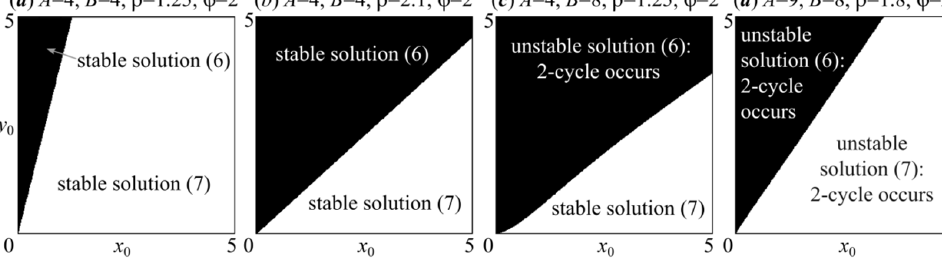
Figure 3. Attraction basins of bi-stable dynamics modes of model (4).